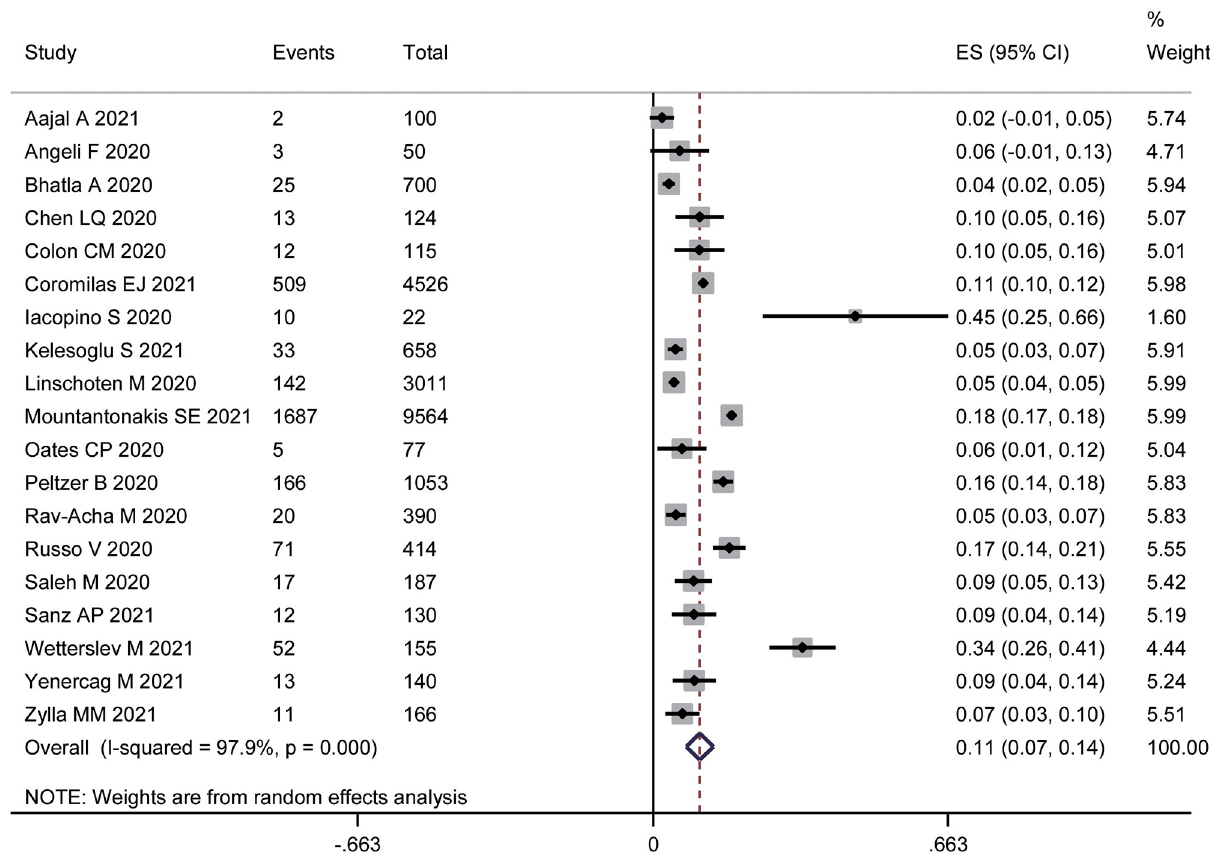
FIGURE 2 | Forest plot of the prevalence of atrial fibrillation in patients with